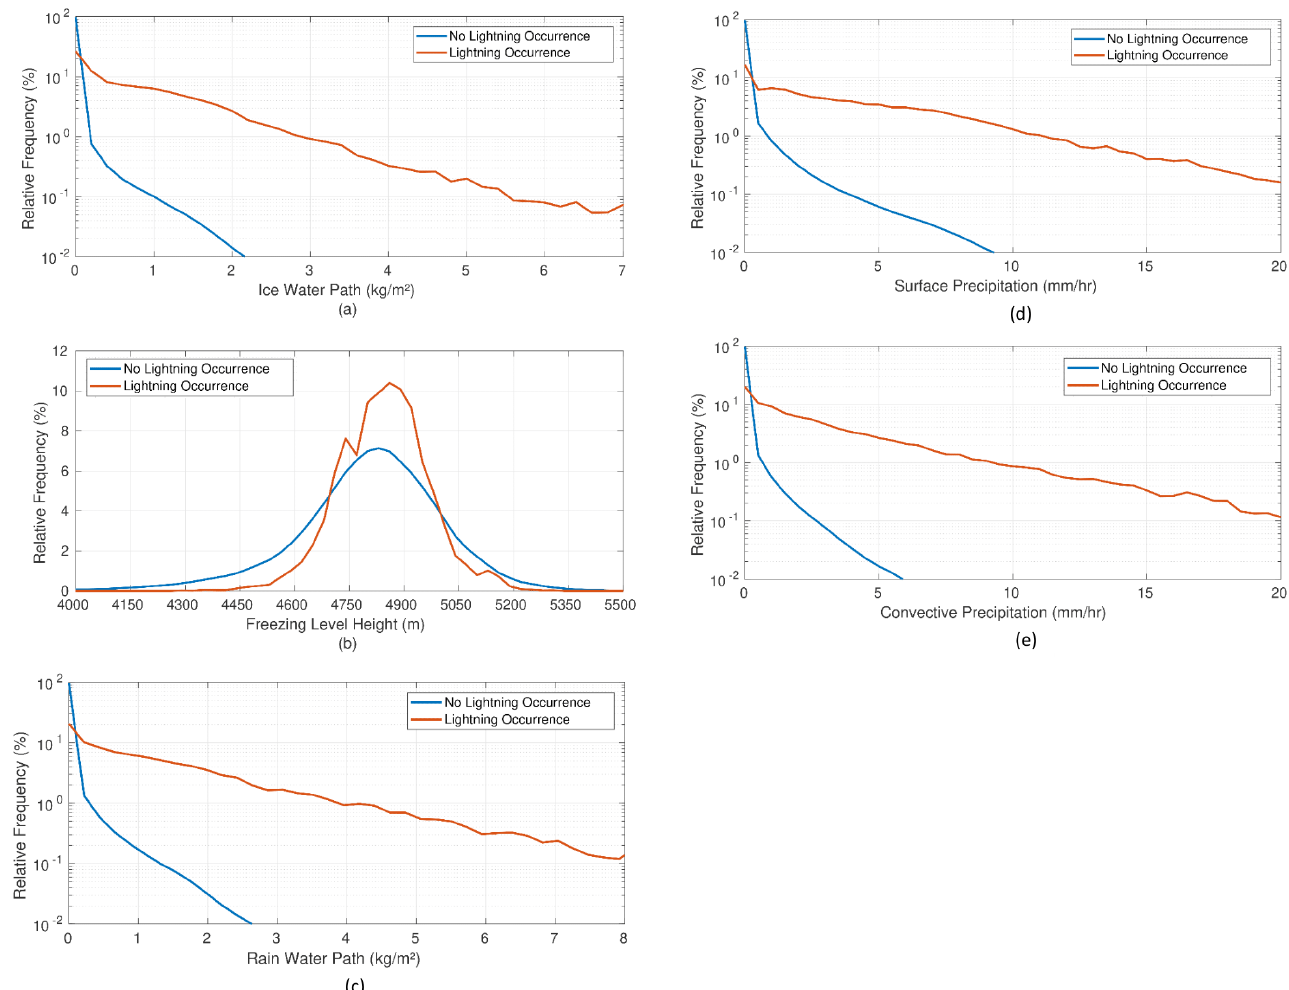
Figure 2. Relative frequency distributions (%) of microphysical properties: ( a ) Ice Water Path, ( b ) Freezing Level Height, ( c ) Rain Water Path, ( d ) Surface Precipitation and ( e ) Convective Precipitation.